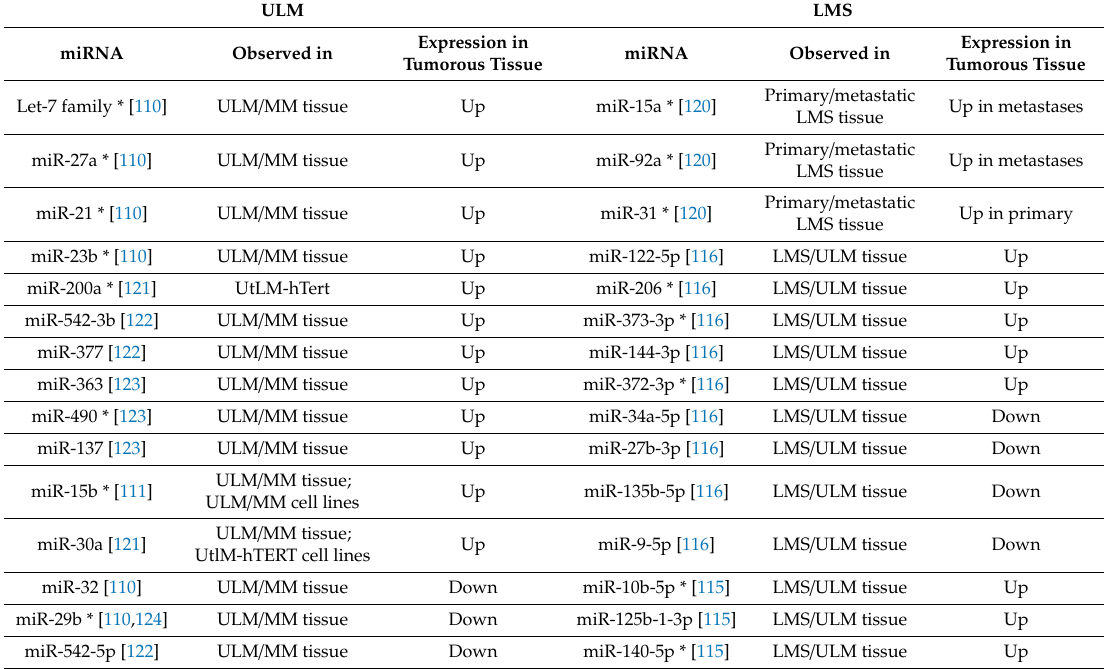
Table 1. Abnormally active microRNAs in ULM and